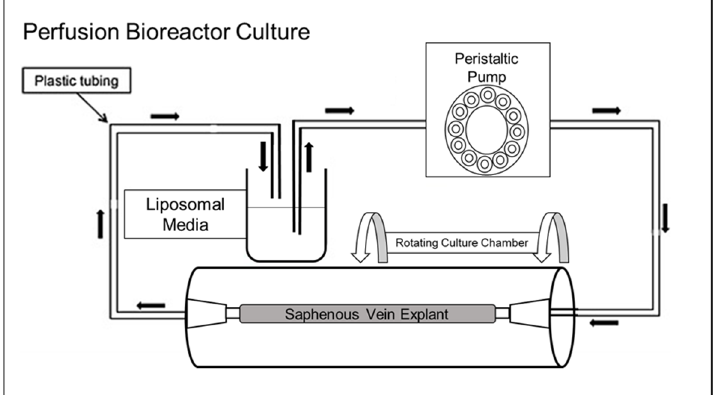
Figure 4. Schematic representation of the bioreactor setup used for human vessel explant perfusion.